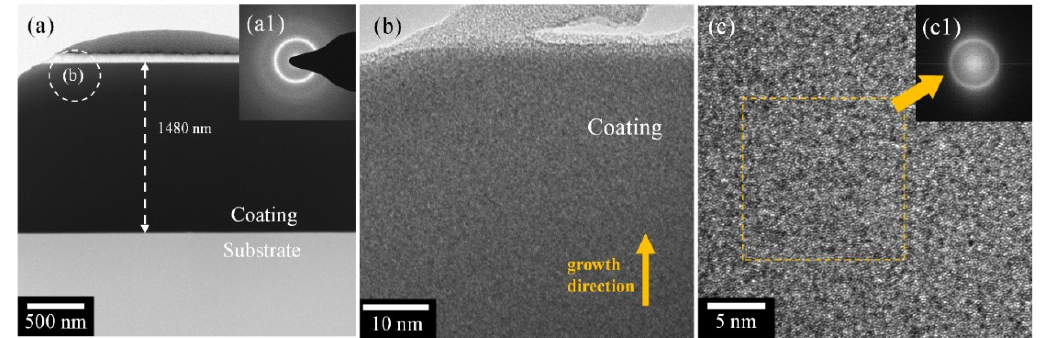
Figure 6. ( a , b ) Bright-field (BF) (( a1 ) inserted selected area electron diffraction (SAED) pattern) and ( c ) high-resolution (HR) (( c1 ) inserted FFT diffractogram) transmission electron microscopy (TEM) images of the Mo–Si–N coating deposited at a N 2 gas flow ratio of 25% and a working pressure of 1 mTorr.